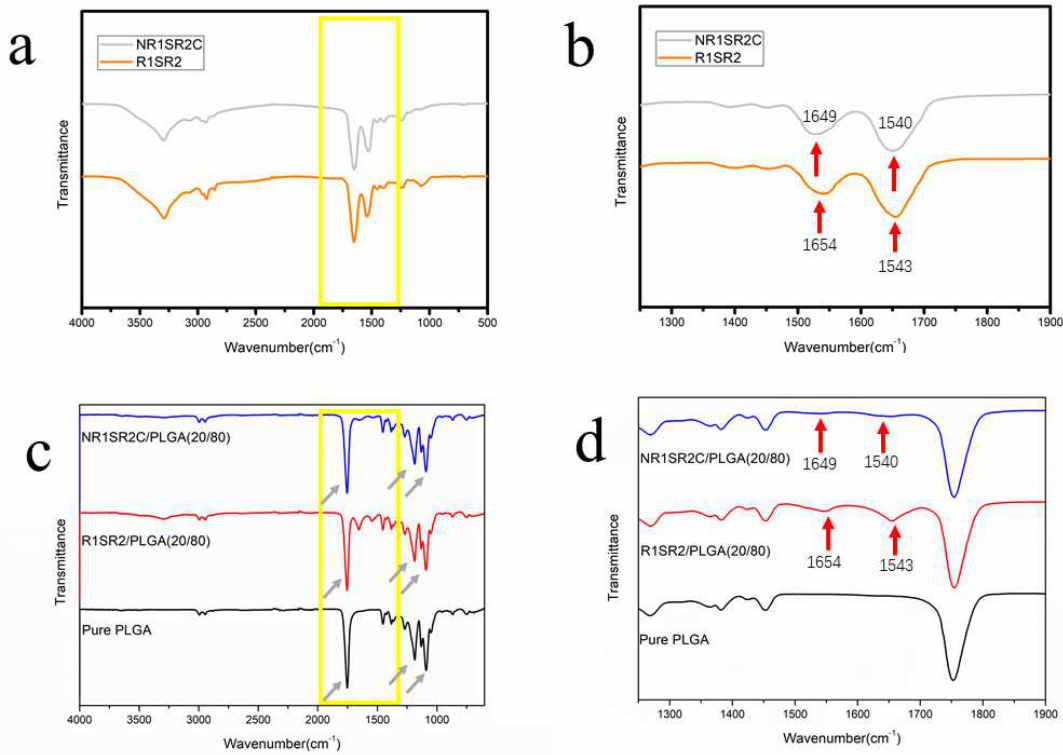
Figure 3. FTIR spectra of recombinant MiSp (NR1SR2C, R1SR2)/PLGA blend scaffolds and pure PLGA scaffolds. Peaks at 1089, 1187 and 1754 cm −1 indicated by arrows in ( c ) correspond to PLGA. ( b , d ), Zoomed-in image of ( a , c ) which in yellow box , from 1250 cm −1 to 1900 cm −1 ; red arrows indicate typical peaks of spidroins’ amide I bands (1600–1700 cm −1 ).